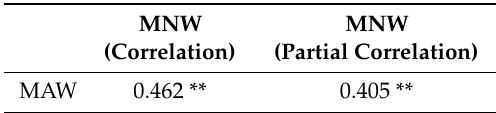
Table 3. Correlations and partial correlations between the maximum width of the nasal aperture and the maximum width of the nose.